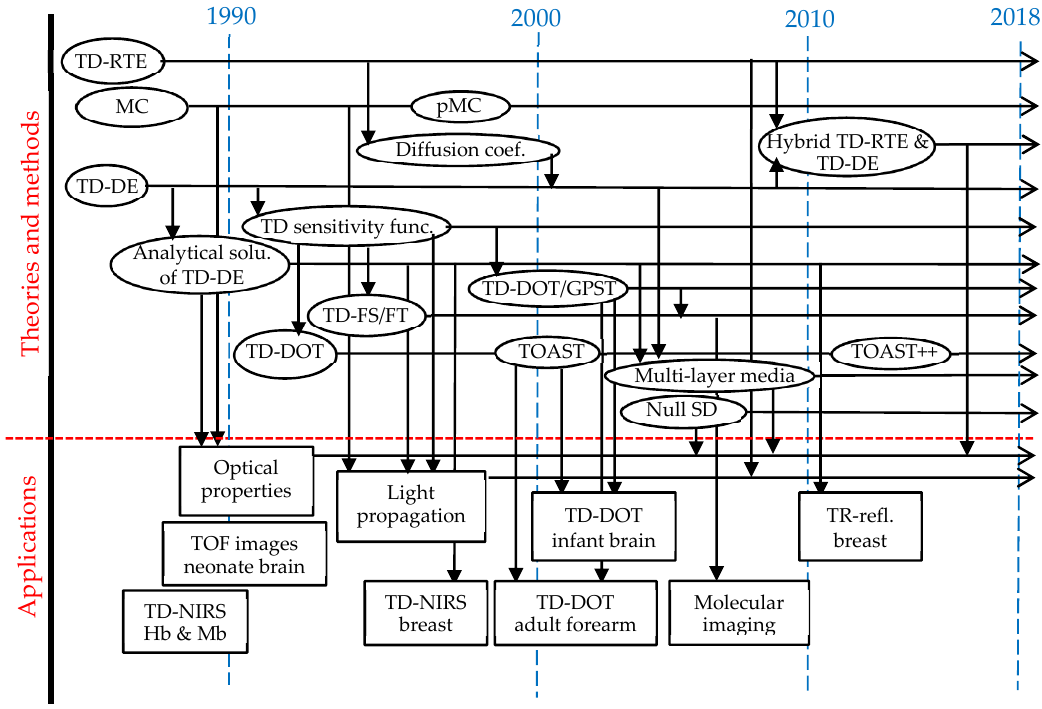
Figure 20. Schematic view of the chronological development of TD-NIRS theories, methods, and applications, indicating their relationship with vertical arrows.